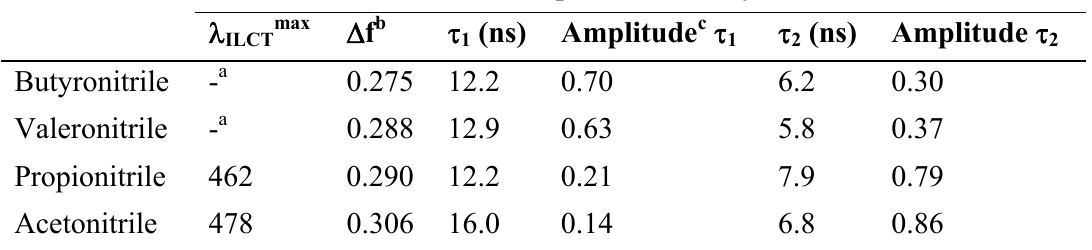
= 310 nm) in nitrile ex